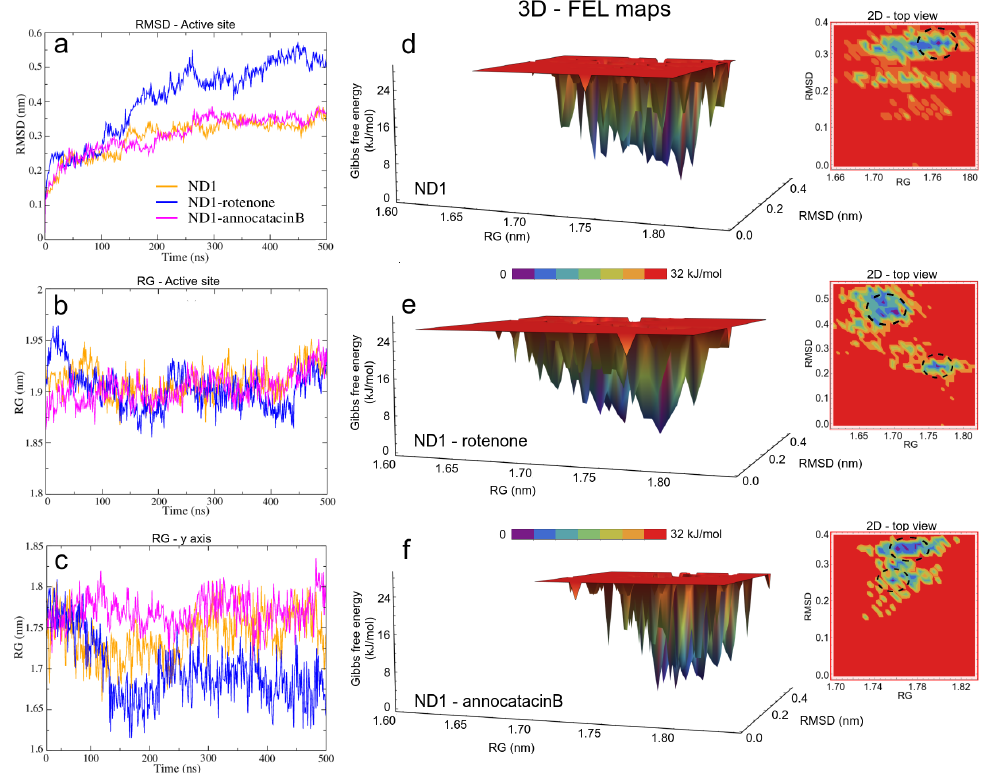
Figure 5. Structural analysis of the ND1 subunit active site. ( a ) RMSD; ( b ) RG; ( c ) RG on of y -axis of the ND1 protein. The FEL maps ( d – f ) were built using structural coordinates from RMSD results and RG on the y -axis. The dash circles in the 2D plots indicate the global minimum energy structures showed in purple color in the 3D